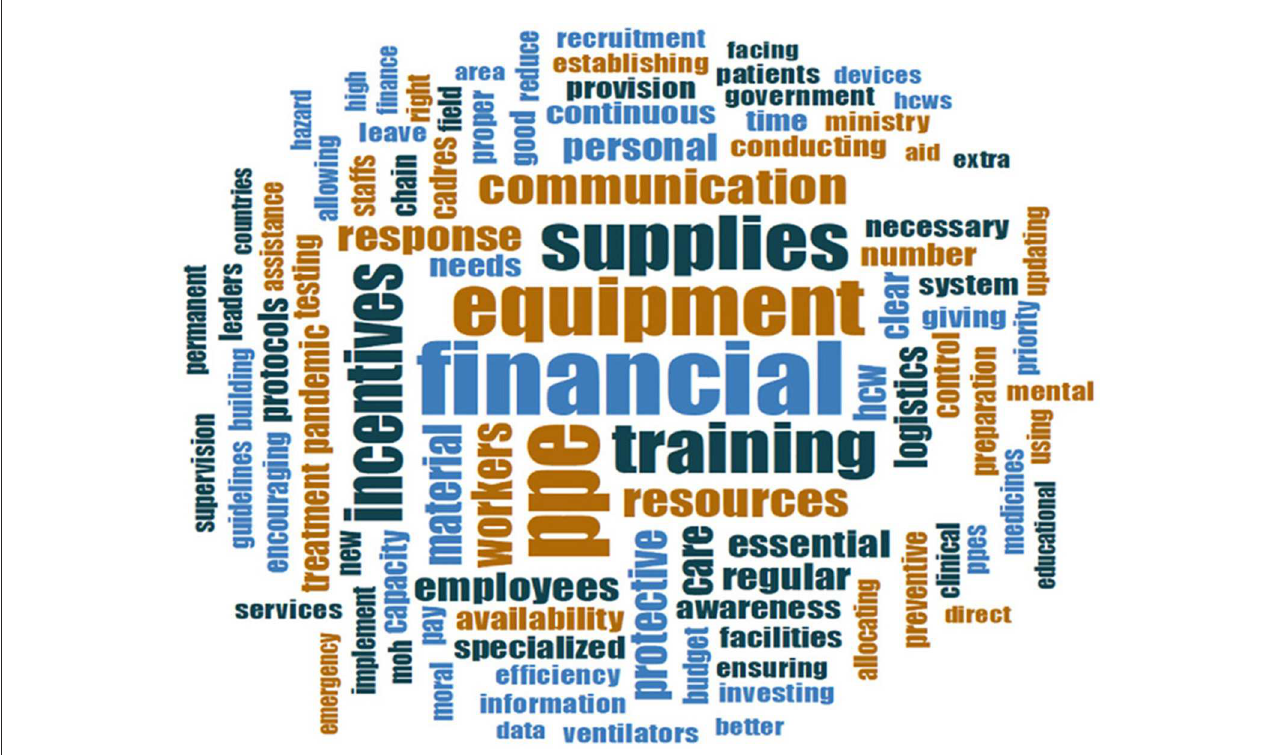
FIGURE3 Word cloud of qualitative responses on hospitals expectations from MOH in enabling recovery from